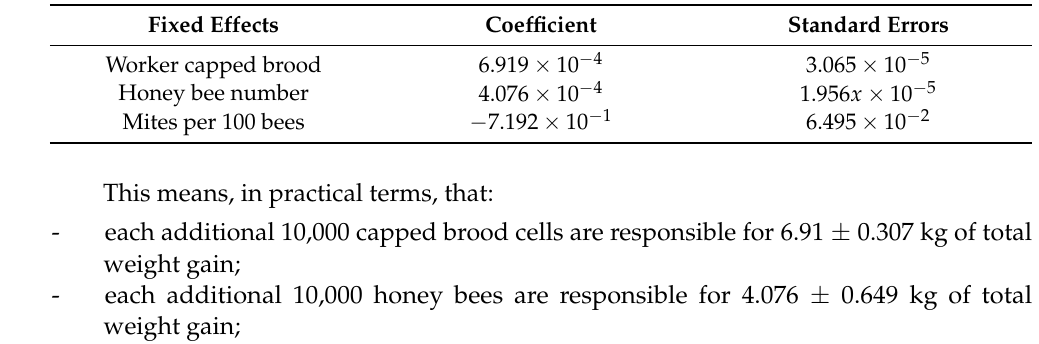
Table 2. Coefficients and standard errors for the fixed effects of model